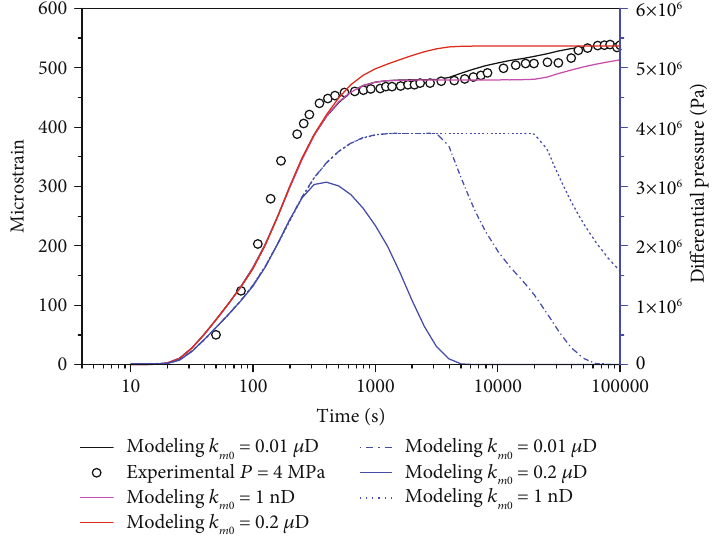
Figure 13: Parameter analysis of responses of bulk deformation of the coal sample to di ff erent initial matrix/cleat permeability